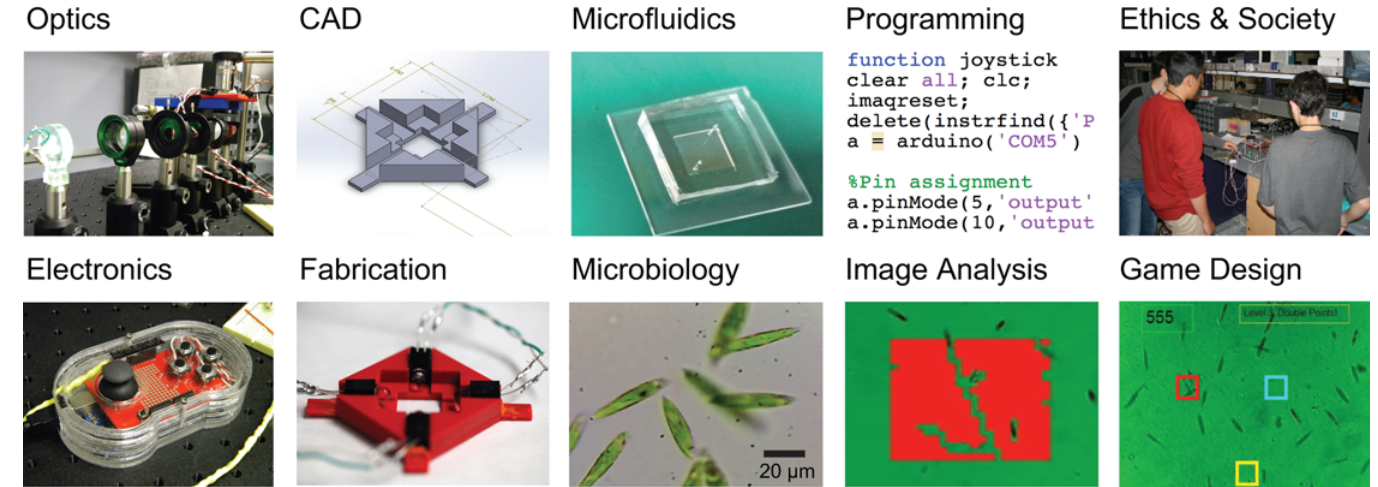
Fig 2. Biotic game-based courses encourage students to integrate a versatile set of relevant STEM topics. Image credits: Taken by N. J. C. (credit for the work and artifacts to the students who took the course).